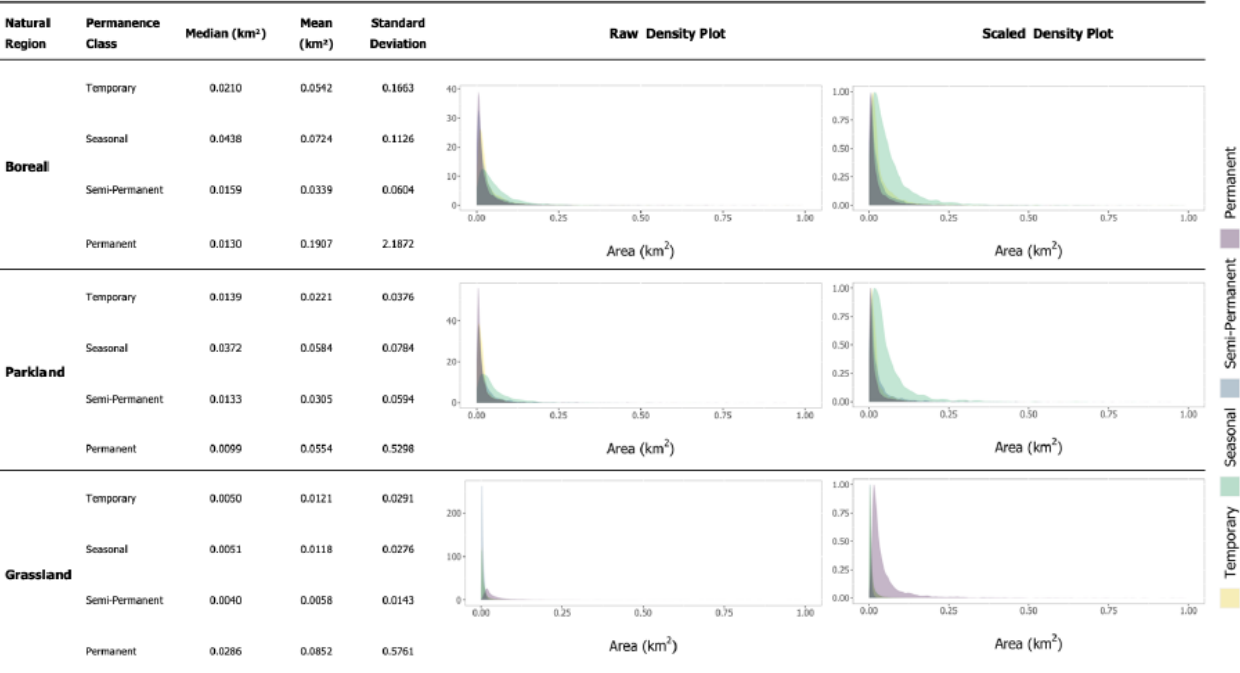
Table A1. Frequency distribution of wetland sizes in the Boreal Forest, Grassland and Parkland natural regions. Data on wetland sizes were acquired from the Alberta Merged Wetland Inventory (Government of Alberta,